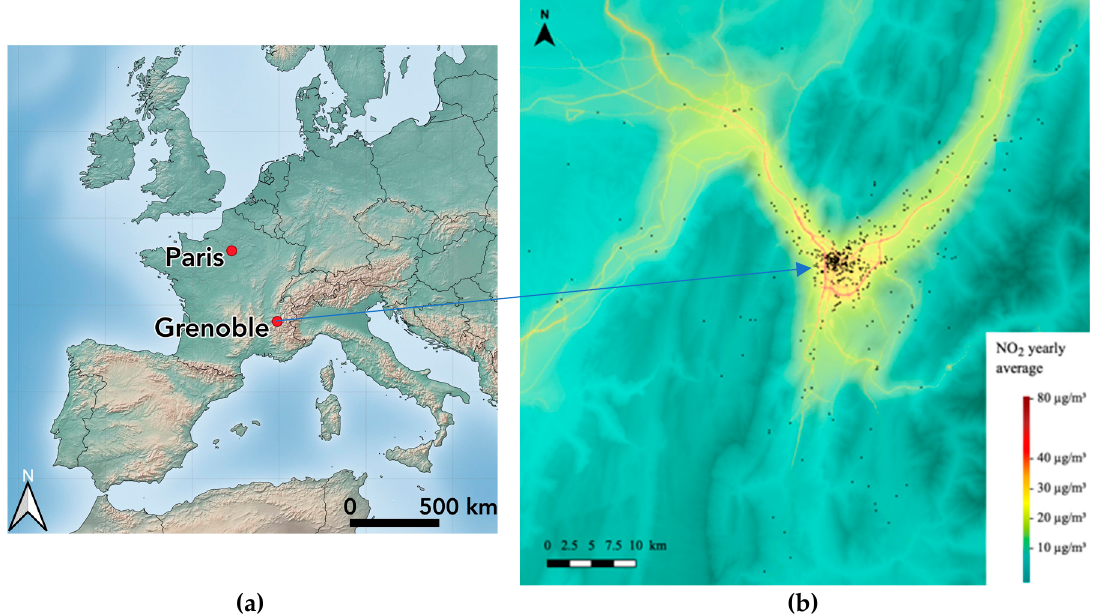
Figure 1. ( a ) Map of Europe and ( b ) of the cohort study area, indicating the yearly NO 2 level (µg/m 3 , 2016) superimposed with the volunteers’ home addresses. Source: Atmo Auvergne Rhône-Alpes.